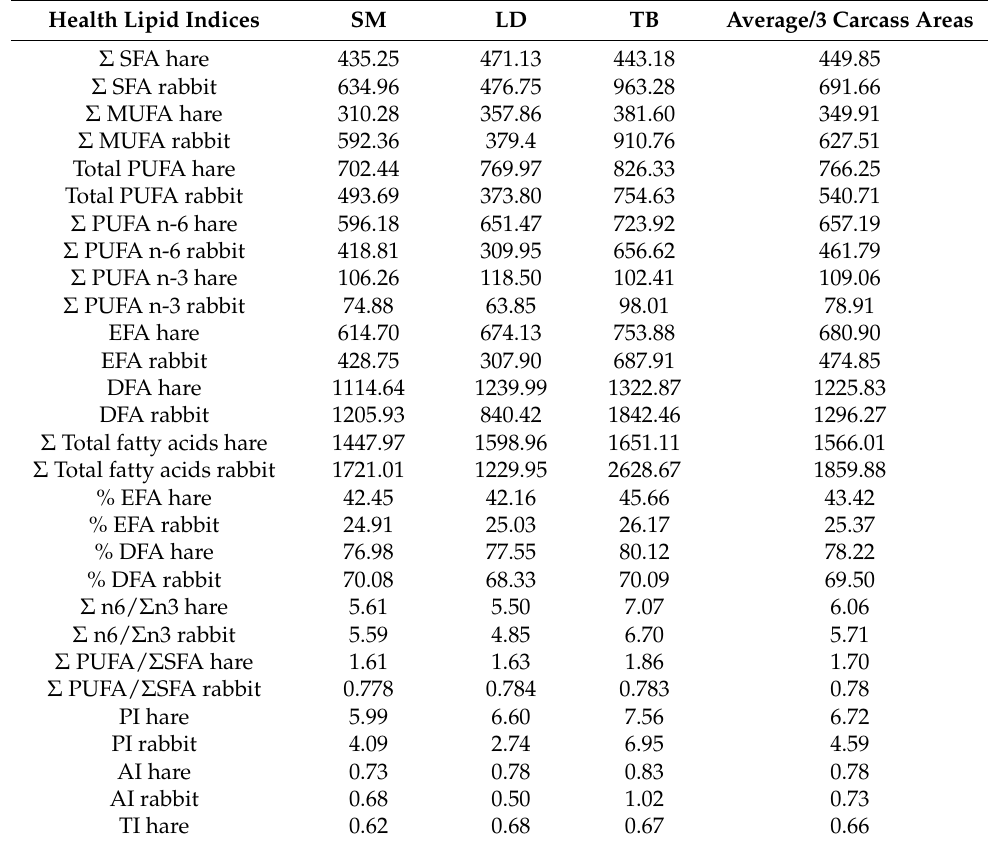
Table 4. Total fatty acids and health lipid indices for hare and rabbit meat (mg/100 g